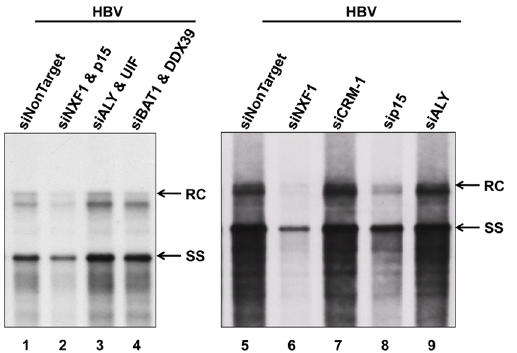
HBV DNA synthesis. HuH-7 cells were transiently co-transfected with an HBV genome (plasmid pCHT-9/3091) and siRNAs, followed by Southern blot analysis using HBV probe (nt 1521–3164) (Fig. 1). Upon treatment with siRNAs specific for p15 or NXF1-p15 complex, HBV replication was significantly inhibited. In contrast, no apparent effect on HBV replication was noted by treatment with various siRNAs specific for TREX components and CRM-1. RC: relaxed circle DNA, and SS: single- strand DNA.